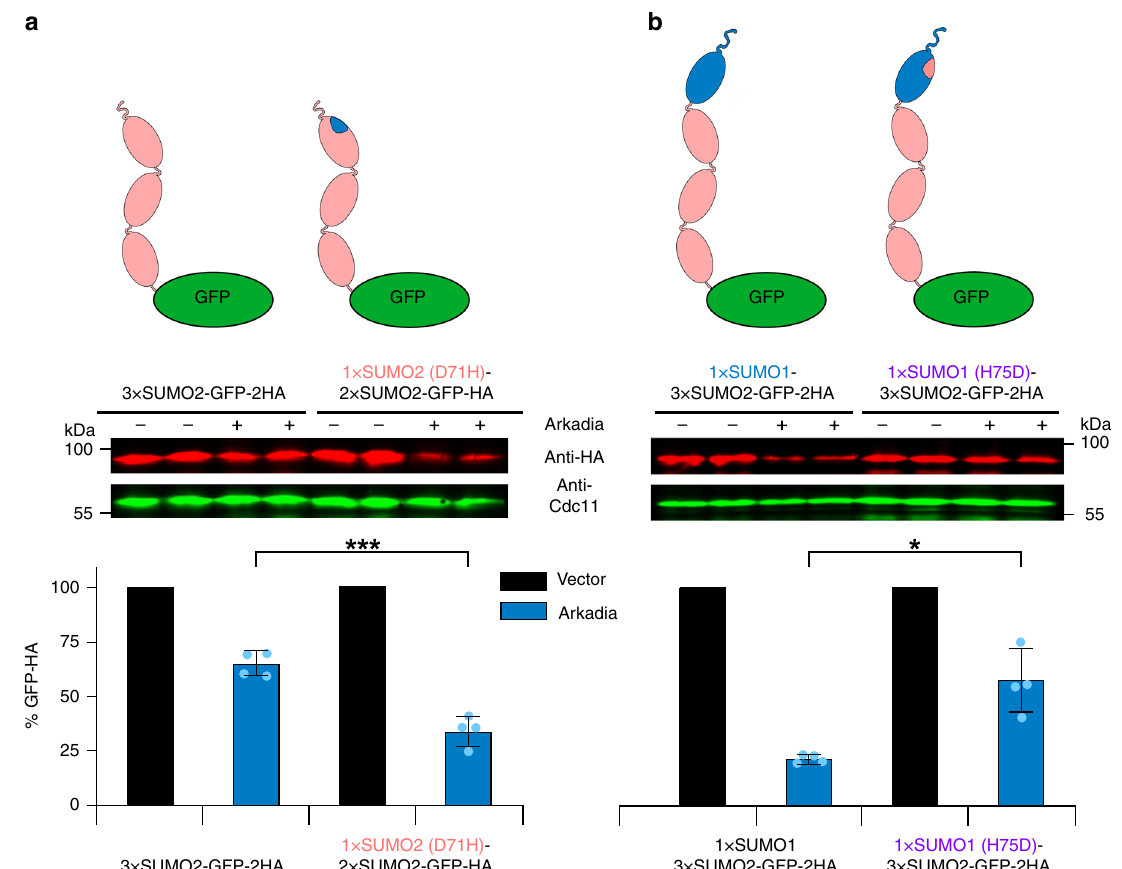
Fig. 4 Arkadia SOB binding site in SUMO1 is distinct from that of canonical SIMs. a Shown is the analysis of targeting ef fi ciency by wild-type Arkadia upon its co-expression with two otherwise identical 3xSUMO2-GFP substrates differing by the presence of a single amino acid residue exchange (D71H) in the fi rst SUMO2 moiety. b Analysis of targeting ef fi ciencies by wild-type Arkadia of otherwise identical SUMO1-3xSUMO2-GFP substrates distinguished by a single amino acid exchange (H75D) in SUMO1. Bars represent the means. Standard deviations (SD) are indicated by error bars. Quanti fi cations are derived from experiments with four independent transformants for each plasmid combination. Asterisks indicate signi fi cant differences with p -values < 0.02 (one), p -values < 0.001 (three). Statistical signi fi cance was determined with unpaired and two-sided Student ’ s t -tests. Source data are provided as a